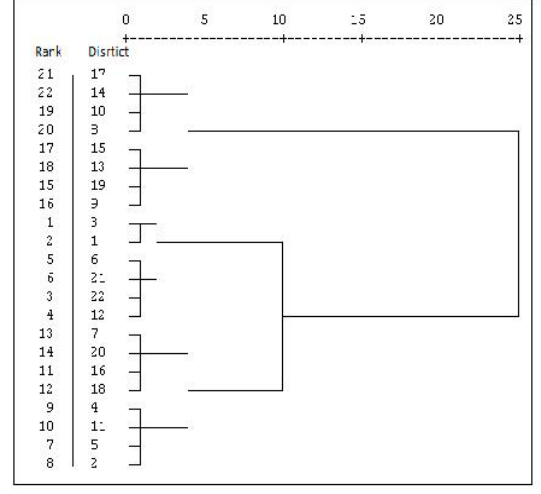
Fig. 2: Tree draw, Cluster analysis